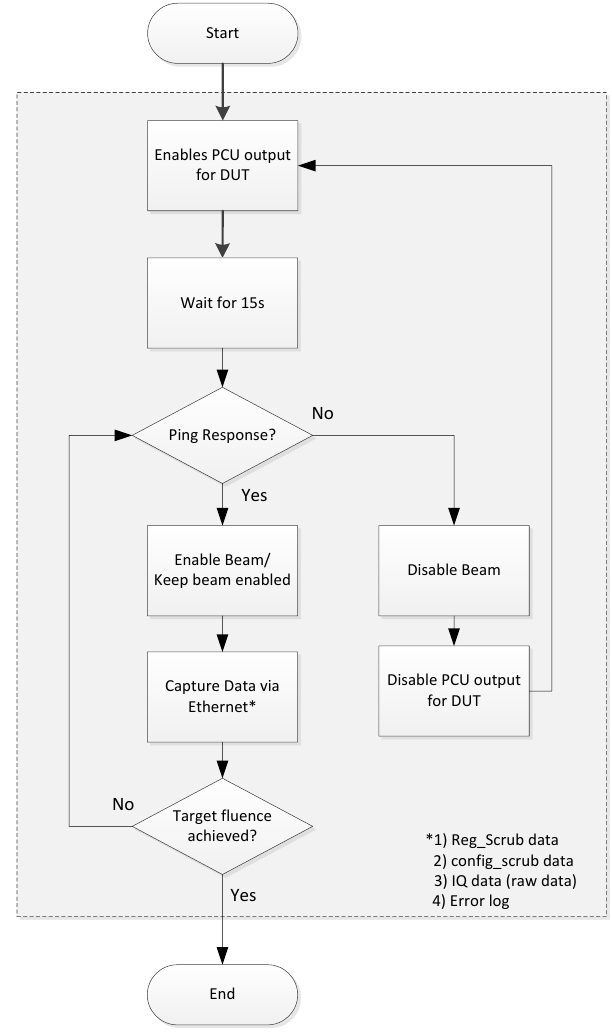
Figure 7. SEE software control flow